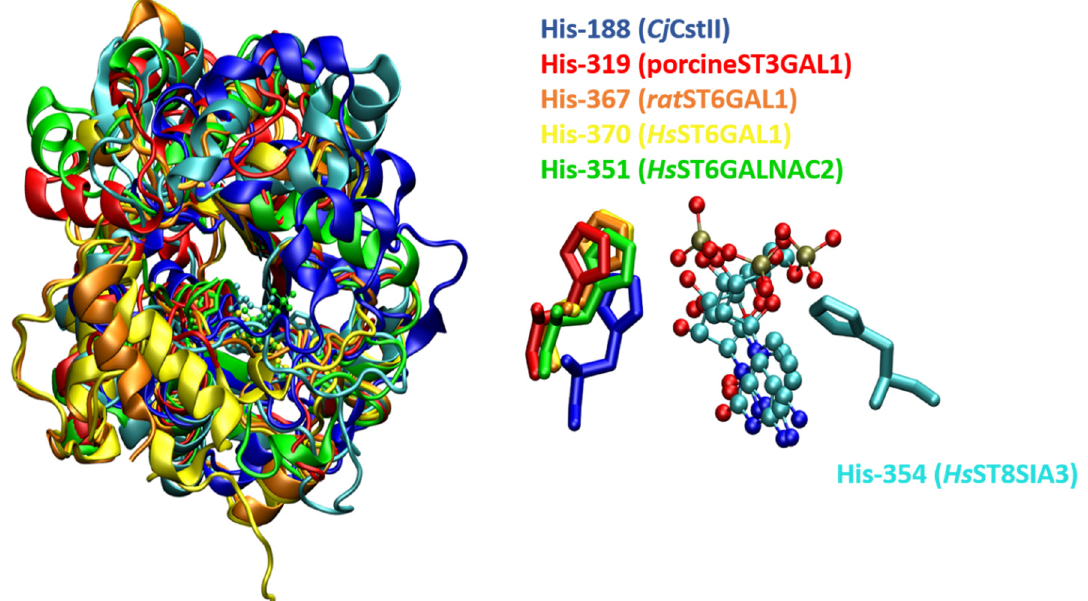
Figure 4. Structural superimposition of the backbone of sialyltransferases from C. jejuni CstII (blue, PDB id: 1RO7), porcine ST3GAL1 GAL1 (red, PDB id: 2WML), ratST6GAL1 (orange, PDB id:4MPS), Hs ST6GAL1 (yellow, PDB id: 4JS1), Hs ST6GALNAC2 (green, PDB id: 6APL), and Hs ST8SIA3 (cyan, PDB id: 5BO6), with the orientation and interaction pattern of histidine residues with the donor substrate.